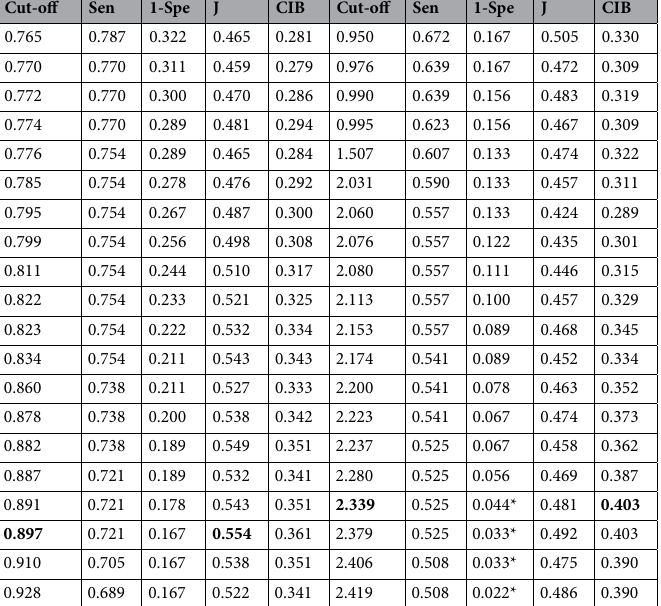
Table 4. Valuating the diagnostic and screening efficacy of tumor marker index (TMI) for gastric cancer with ROC analysis (incidence = 0.05). *The cardinal number is less than 0.05; hence, this value should be assumed as 0.05 to calculate CIB; Boldface: Optimum cut-off